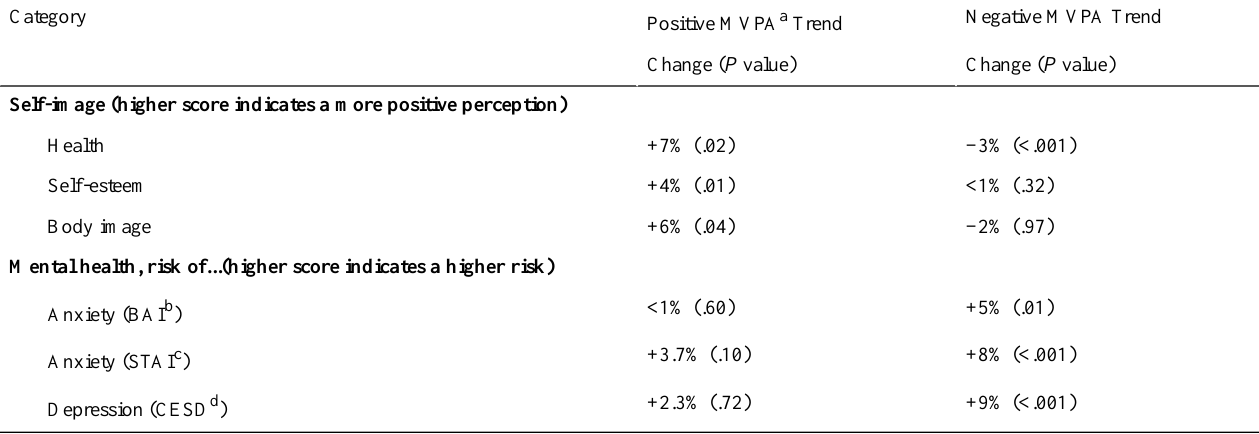
Table 3. Summary of descriptive statistics for moderate-vigorous physical activity trajectories based on survey responses. Change refers to the percent difference between the average score for the first and last survey administered.